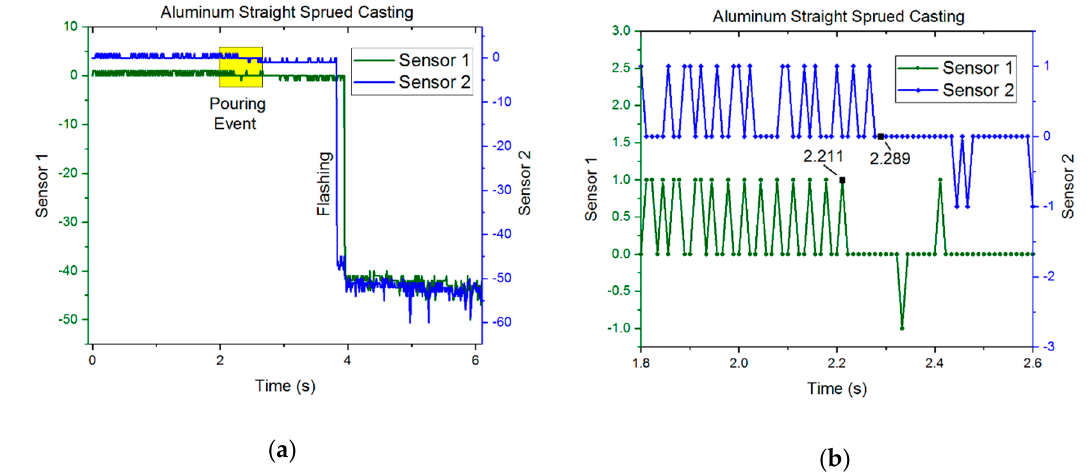
Figure 9. ( a ) Oscillator frequency recorded by the capacitive sensors during the SSC pouring event. ( b ) Oscillator frequency during the pouring event.